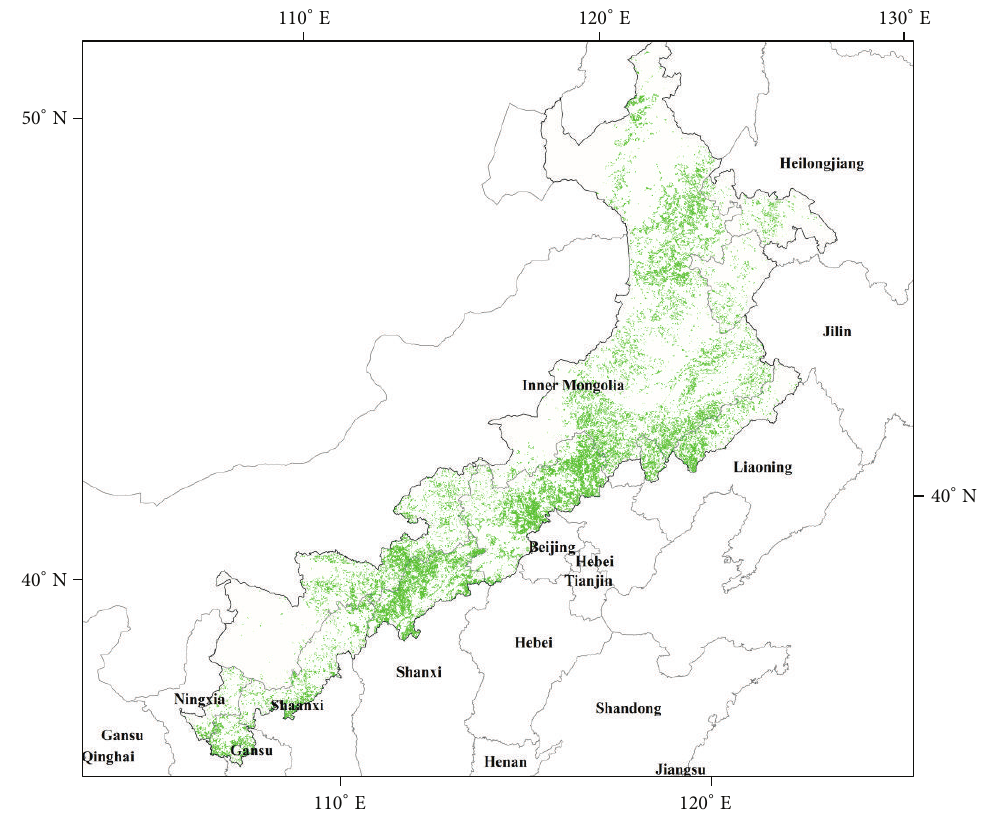
Figure 3: The distribution of cropland/natural vegetation mosaics in 1km grid all over North